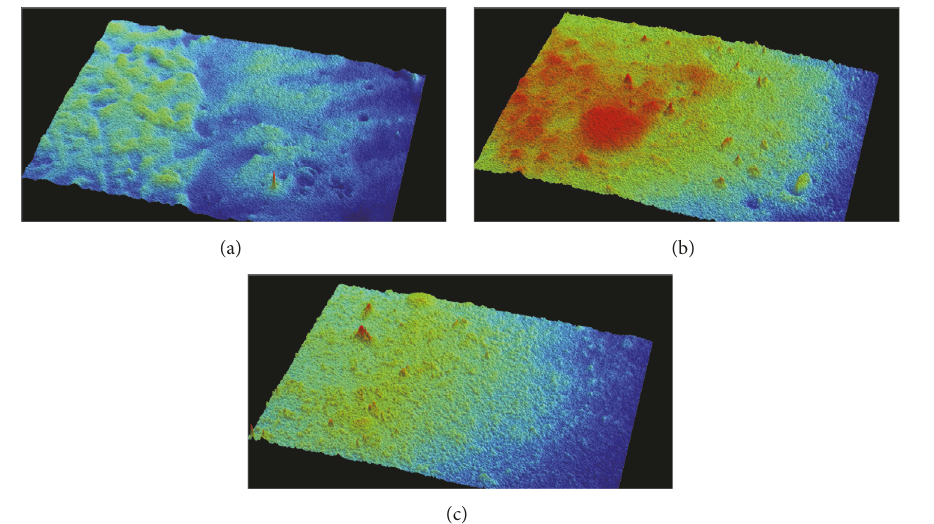
Figure 2: Representative topographic surface maps and surface analysis ( 0.317 × 0.238 mm) of the Ketac Fil Plus Aplicap specimens (magnification × 20). (a) Baseline, (b) abrasive surface (control group), and (c) abrasive surface (radiant heat group).